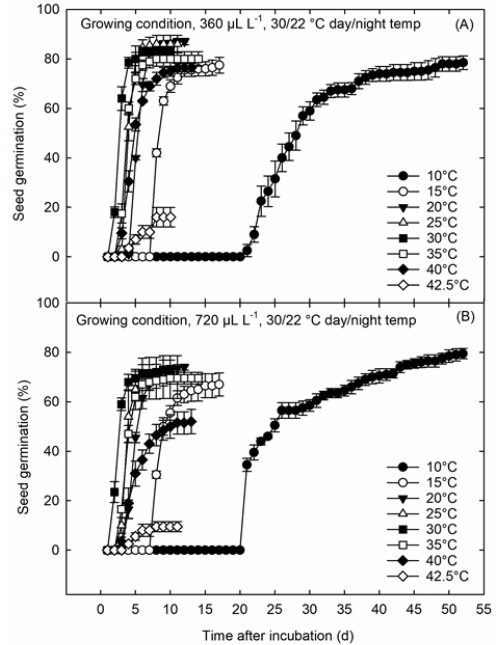
Figure 1. Big bluestem seed germination time course obtained from plants grown under two parental environments representing 30 / 22 ◦ C day / night temperatures under ( A ) 360- µ L L − 1 and ( B ) 720- µ L L − 1 CO 2 concentrations. Data are means ± standard error (SE) of four plants ( n = 4) harvested from a given SPAR unit and used as replicates in statistical analysis for a respective parental environment. Table 2. Description of eight di ff erent parental environments (PEs), CO 2 ( µ L L − 1 ), day / night growth temperature ( GT ), measured mean GT in the chamber, maximum seed germination percentage ( MSG ), temperature adaptability range for maximum seed germination ( TAR MSG ), quadratic equation constants ( a , b , and c ), coe ffi cients of determination ( R 2 ), and cardinal temperatures ( T min , T opt , and T max ) for the MSG of big bluestem seeds grown from eight parental